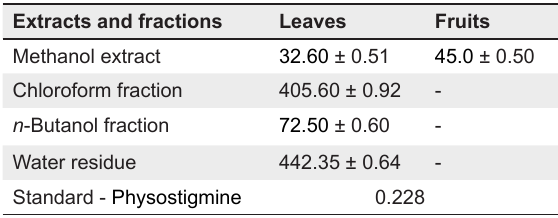
Table 2. Results of the AChE inhibition